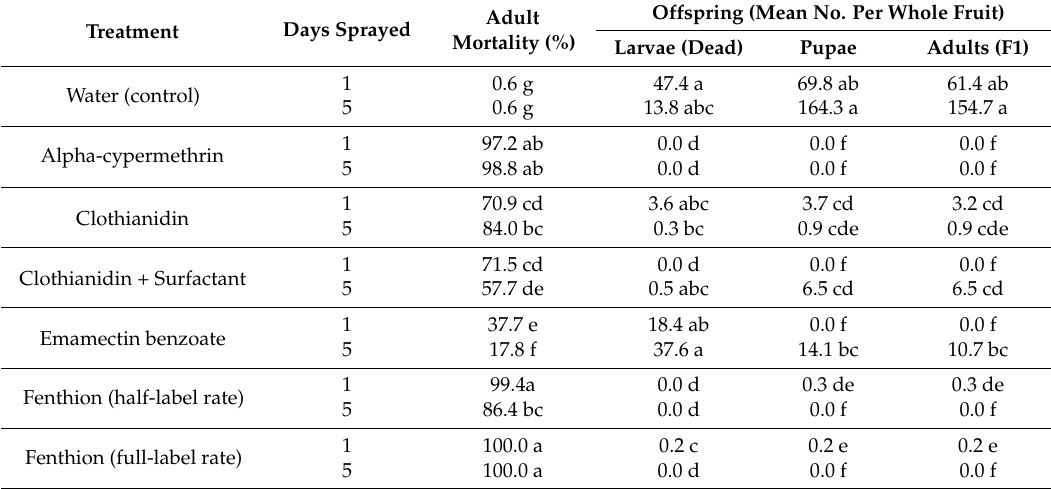
Table 7. Mortality of adult Bactrocera tryoni , after 48 h exposed to one- and five-day old field aged residues of insecticides applied to peach trees, and subsequent